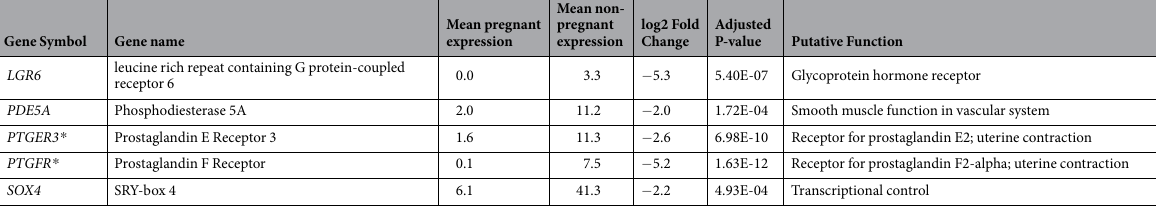
Table 6. Significantly down-regulated genes during pregnancy putatively involved in tissue remodelling, immune function, and transport. The table displays HUGO Gene Symbol of the best BLAST hit, log2 ratios, and FDR‐adjusted p‐values, along with mean expression values per stage. Mean expression values are normalized transcripts per million (TPM). Only genes with adjusted P-values < 0.001 are shown. * indicates top 100 differentially expressed